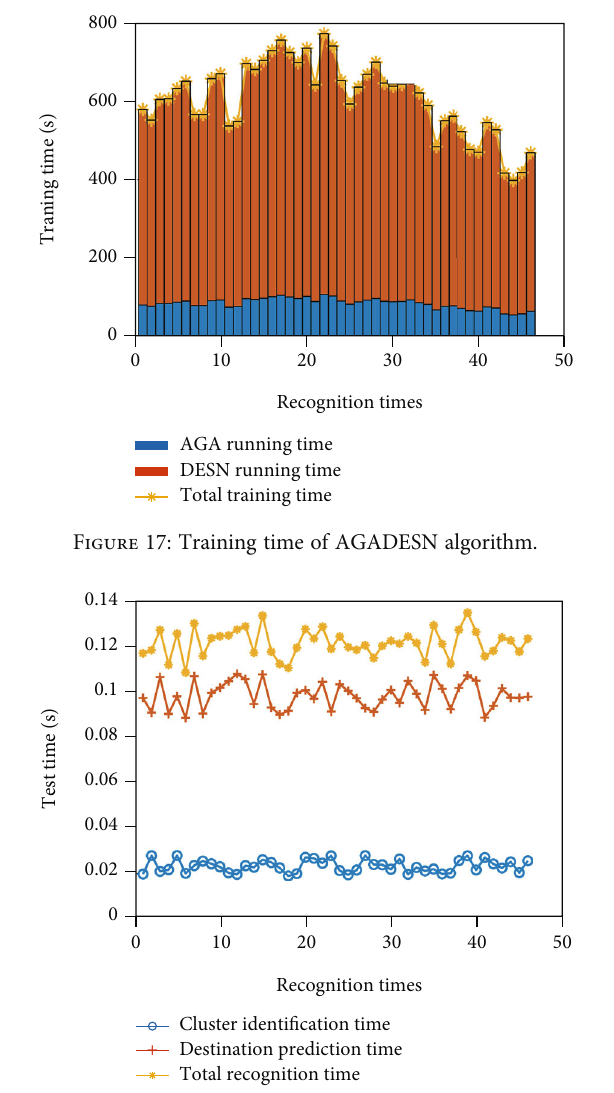
Figure 18: Average time of intention recognition under single test